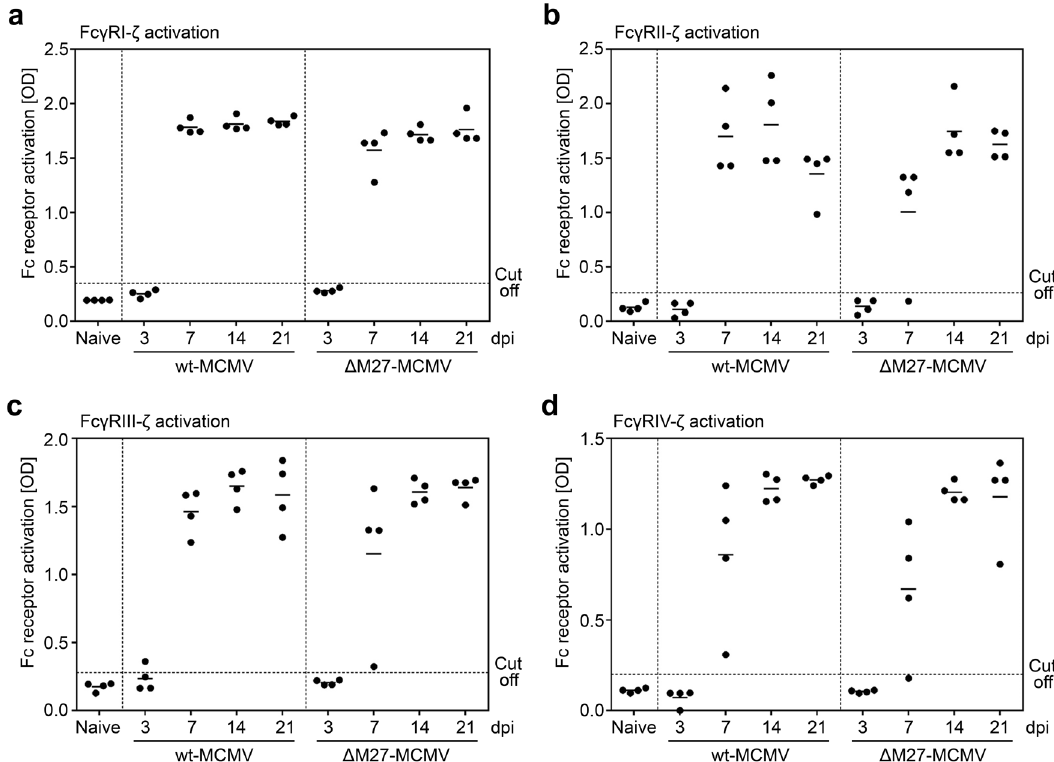
Fig. 6 Immunization of BALB/c mice with Δ M27-MCMV raises strong MCMV-speci fi c Fc γ R-activating IgG responses. BALB/c mice were infected i.p. with wt-MCMV or Δ M27-MCMV. At 3, 7, 14, and 21 dpi, serum samples were collected. Fc γ receptor-activating capacity was quanti fi ed from sera by mIL-2 ELISA using a surrogate assay as described in the M&M section and in reference 37 . The mean values as well as the values of individual mice ( n = 4 per group) are shown. a Activation assay for mFc γ RI. b Activation assay for mFc γ RII. c Activation assay for mFc γ RIII. d Activation assay for mFc γ